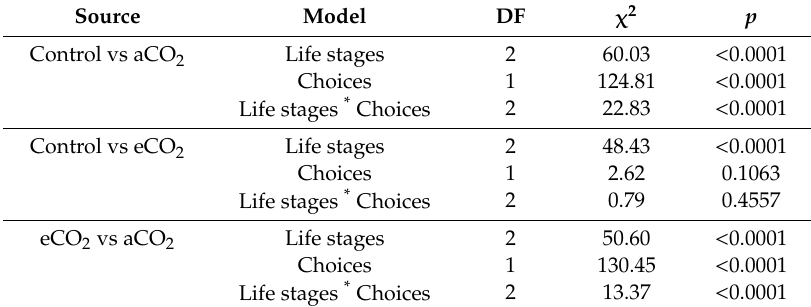
Table 1. Summary of a general linear model (GLM) analysis of the effect of life stages (nymphs, wingless and winged adults) and choices on residence duration of Rhopalosiphon maidis in Y tube olfactometer, during three dual choices including control, aCO 2 and eCO 2 barley seedling combinations.